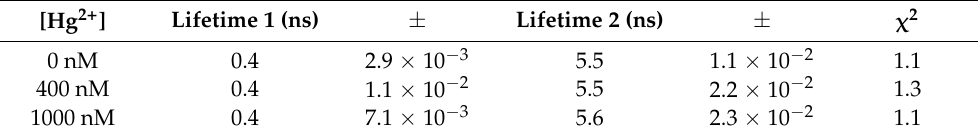
Table 1. Fluorescence lifetimes of FG-CDs at increasing concentrations of mercury (II). ions. [Hg 2+